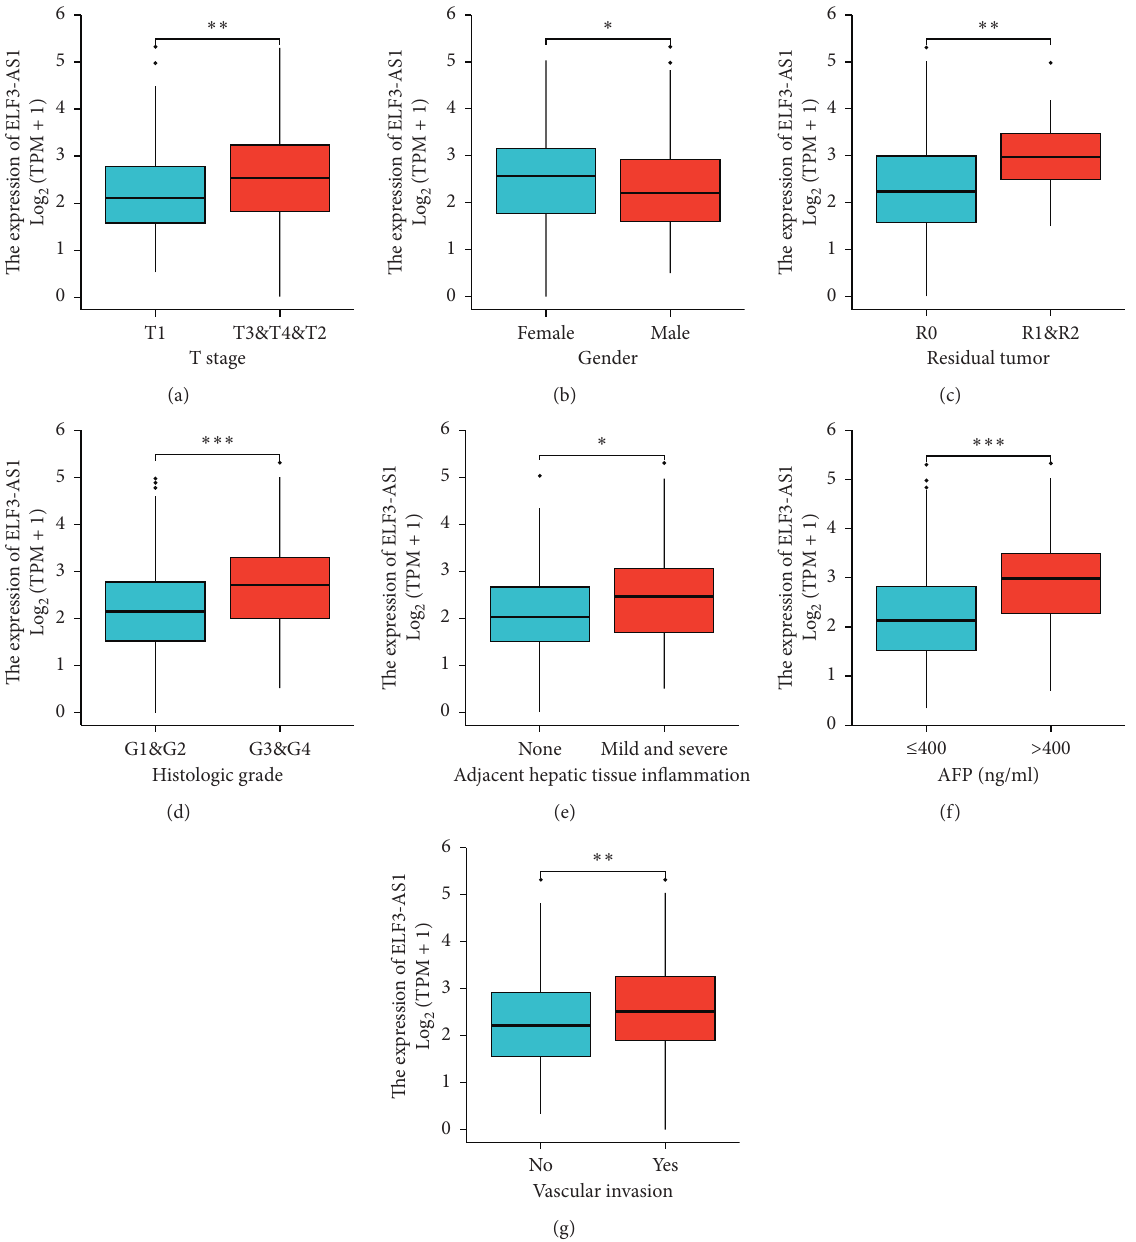
Figure 2: ELF3-AS1 expression in HCC was significantly associated with clinical characteristics. (a) Tstage. (b) Gender. (c) Residual tumor. (d) Histological grade. (e) Adjacent hepatic tissue inflammation. (f) AFP. (g) Vascular